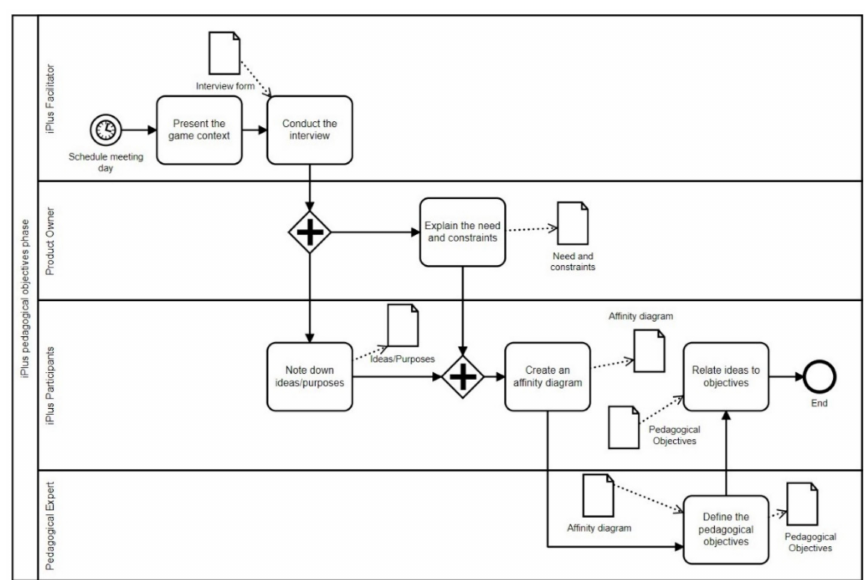
Figure 4. Pedagogical Objectives Phase Process.